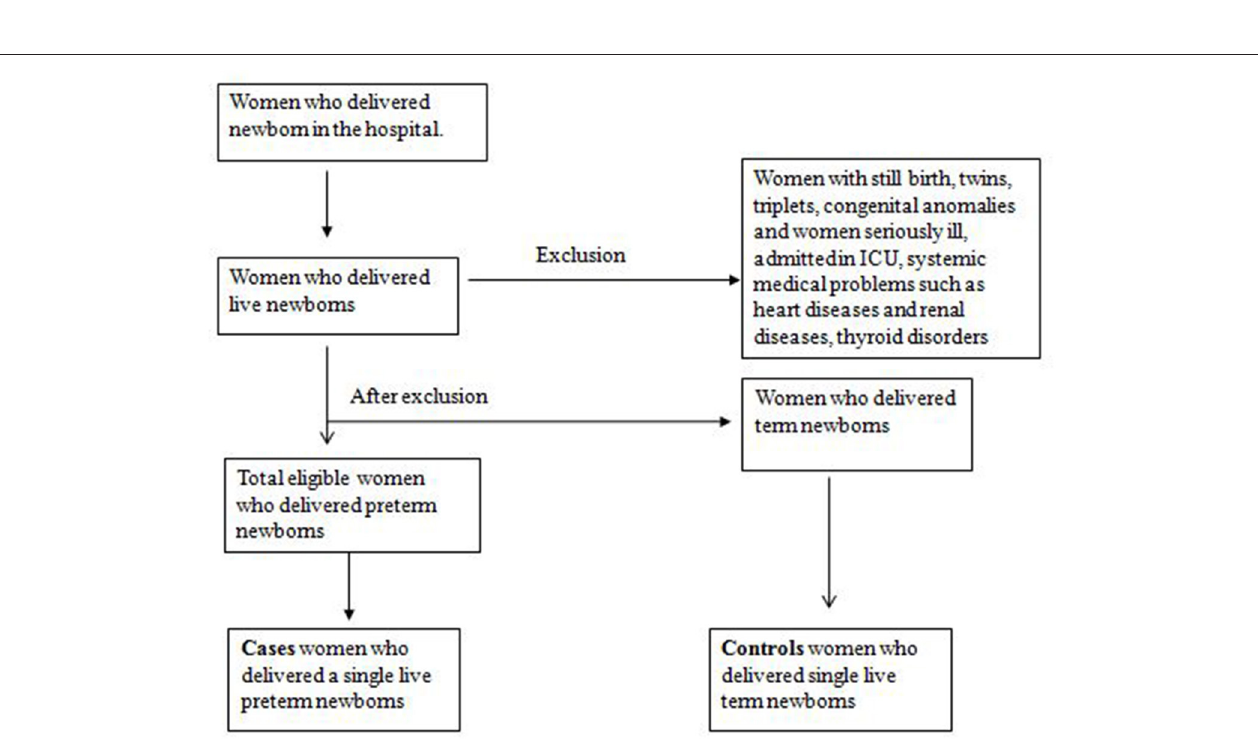
FIGURE 2 | Sampling